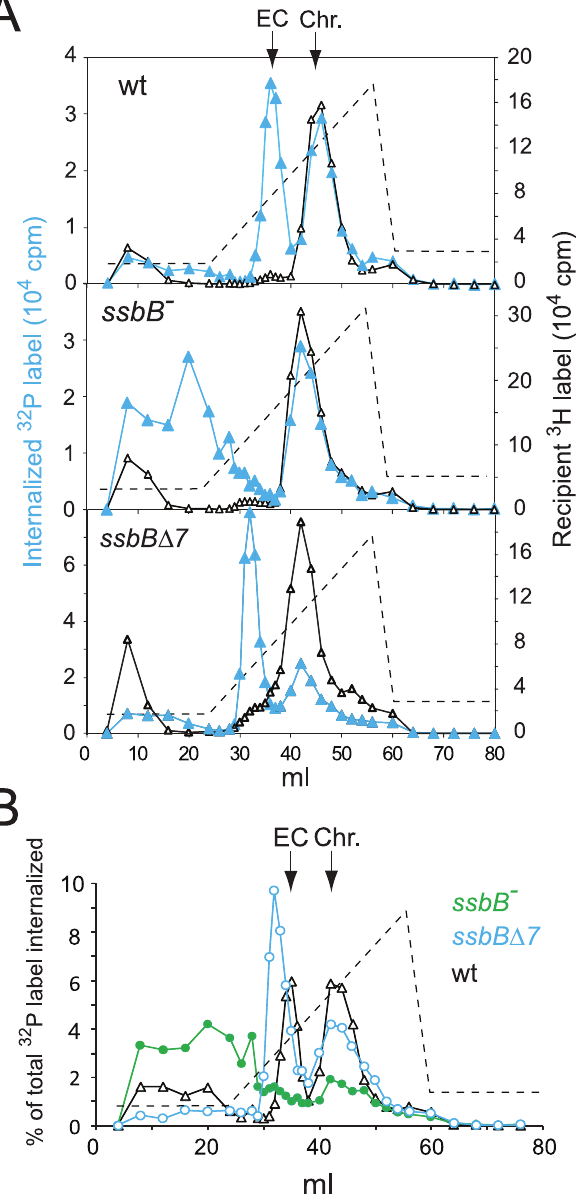
Figure 3. Analysis of EC in wildtype, ssbB 2 , and ssbB D 7 cells. (A) HAP chromatography of extracts from transformed wildtype (R2512), ssbB D 7 (R2583) and ssbB 2 (R2582) cells were run in parallel. Competent cells, pre-labeled with 3 H-thymidine, were exposed for 5 min at 30 u C to a mixture of unlabeled chromosomal DNA and a 32 P-labeled 10,380-bp homologous fragment, then treated with DNase I for 1 min before lysis; preparation of cell extracts, chromatography on HAP and elution with a PBgradient were asdescribed in MaterialandMethods.Blue symbols and lines, 32 P donor label; black symbols and lines, 3 H recipient label. Vertical arrows indicate the position of wildtype EC and chromosomal DNA (Chr.). Dotted line, PB gradient. (B) Duplicate (independent from panel A) HAP chromatography analyses of extracts from transformed wildtype (R2512), ssbB D 7 (R2583) and ssbB 2 (R2582) cells run in parallel. Recipient 3 H chromosome label profiles have been omitted for clarity.